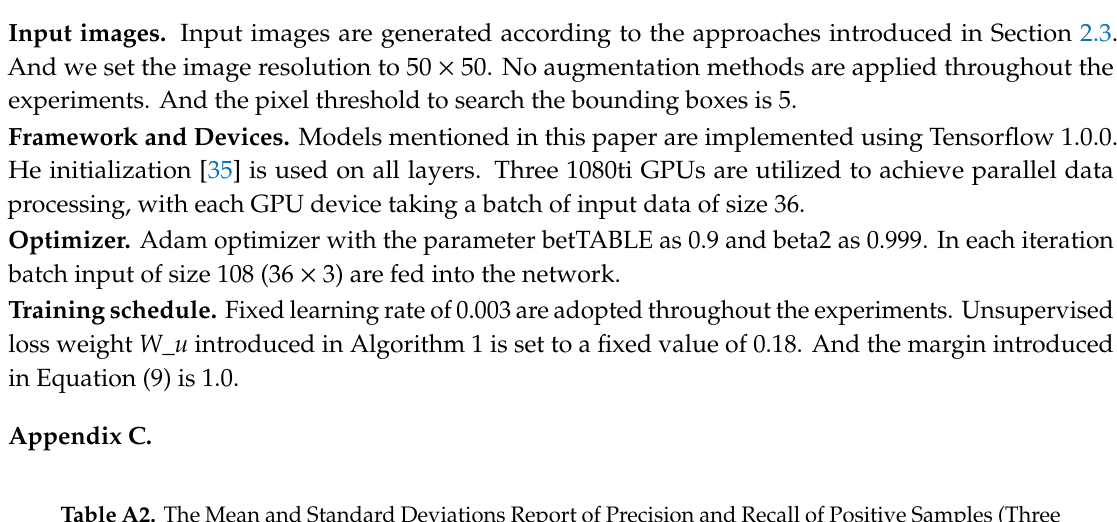
Table A2. The Mean and Standard Deviations Report of Precision and Recall of Positive Samples (Three